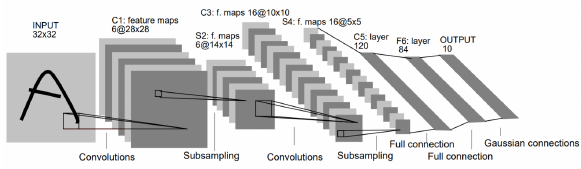
Figure 9. Convolutional neural network (CNN).